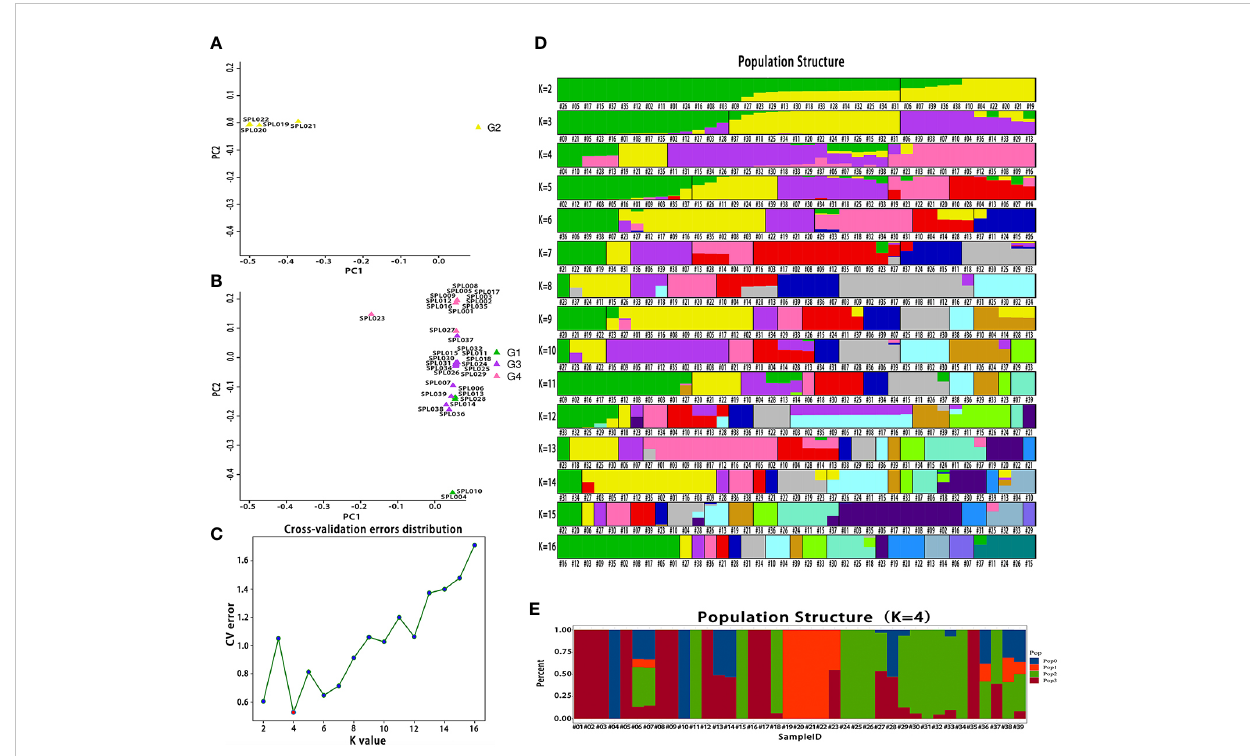
FIGURE 3 Bioinformatic analysis of 39 Lonicera varieties based on single nucleotide polymorphisms (SNPs). (A) A two-dimensional diagram of principal component analysis (PCA). (B) The cross-validation error rate corresponding to different K values. (C) Population structure of 39 Lonicera varieties at different K values. The K value represents the cross-validation error rate. (D) Population structure of 39 Lonicera samples when K = 4.